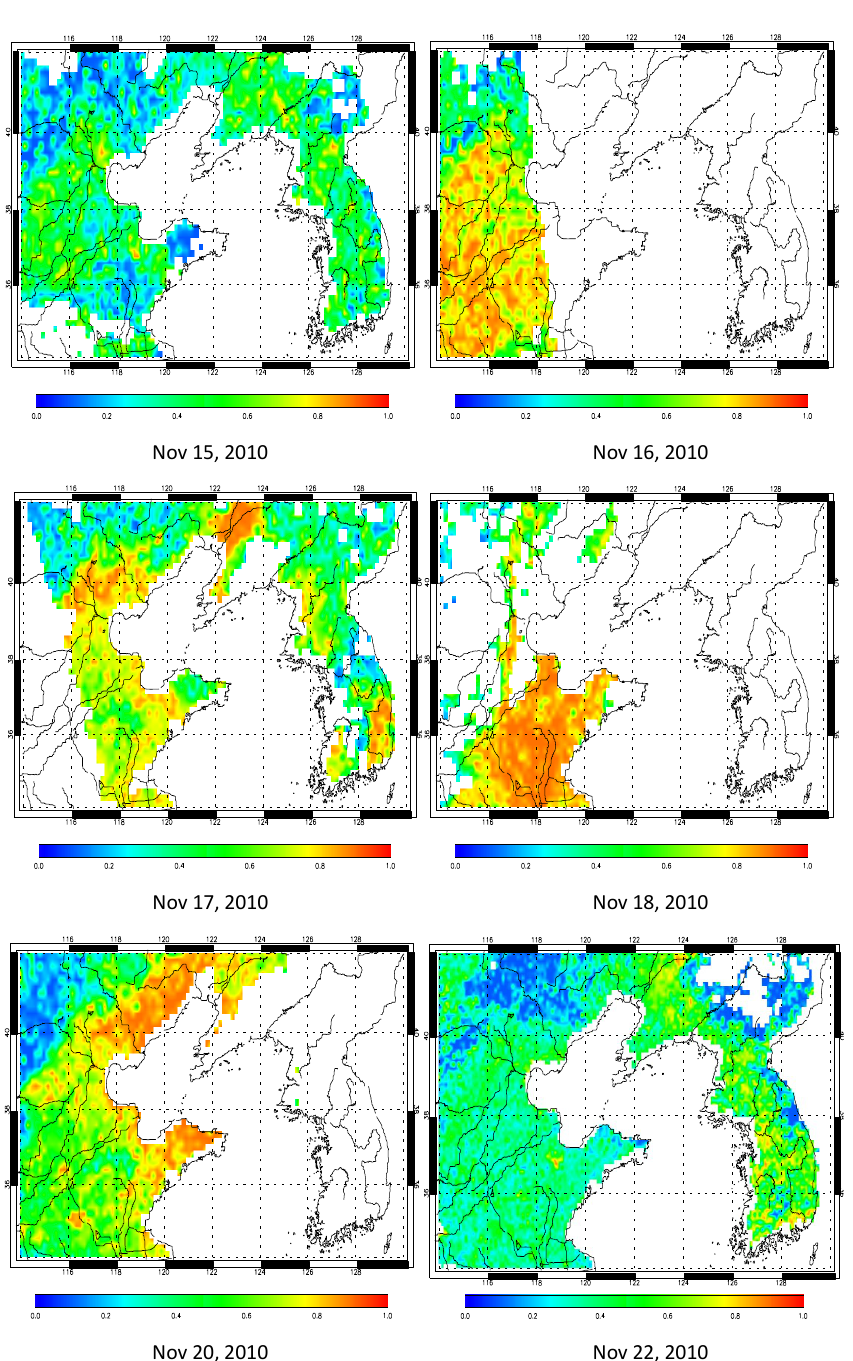
Fig.11. Aerosol fine-mode (FMF) over the East Asia during December 15-22, 2010, except for Fig. 11. Aerosol fine-mode (FMF) over the East Asia during 15–22 December 2010, except for 19 and 21 November due to cloud contami- November 19, and November 21 due to cloud contaminated.